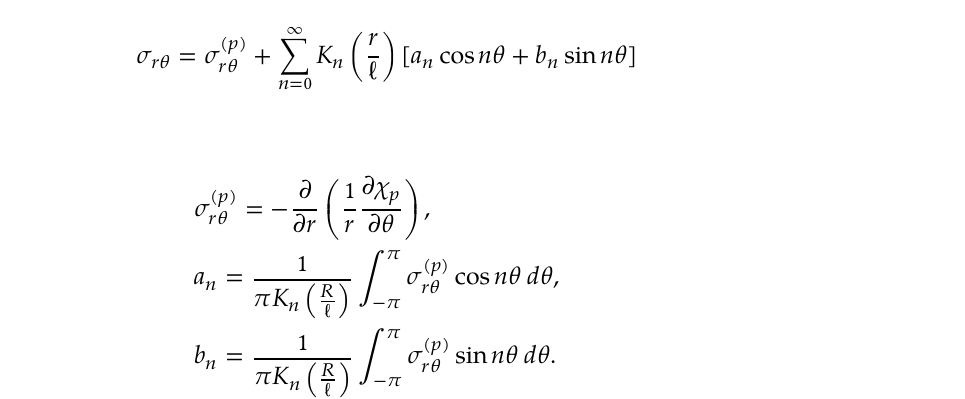
(dashed curve) and gradient solution σ 𝑟𝜃